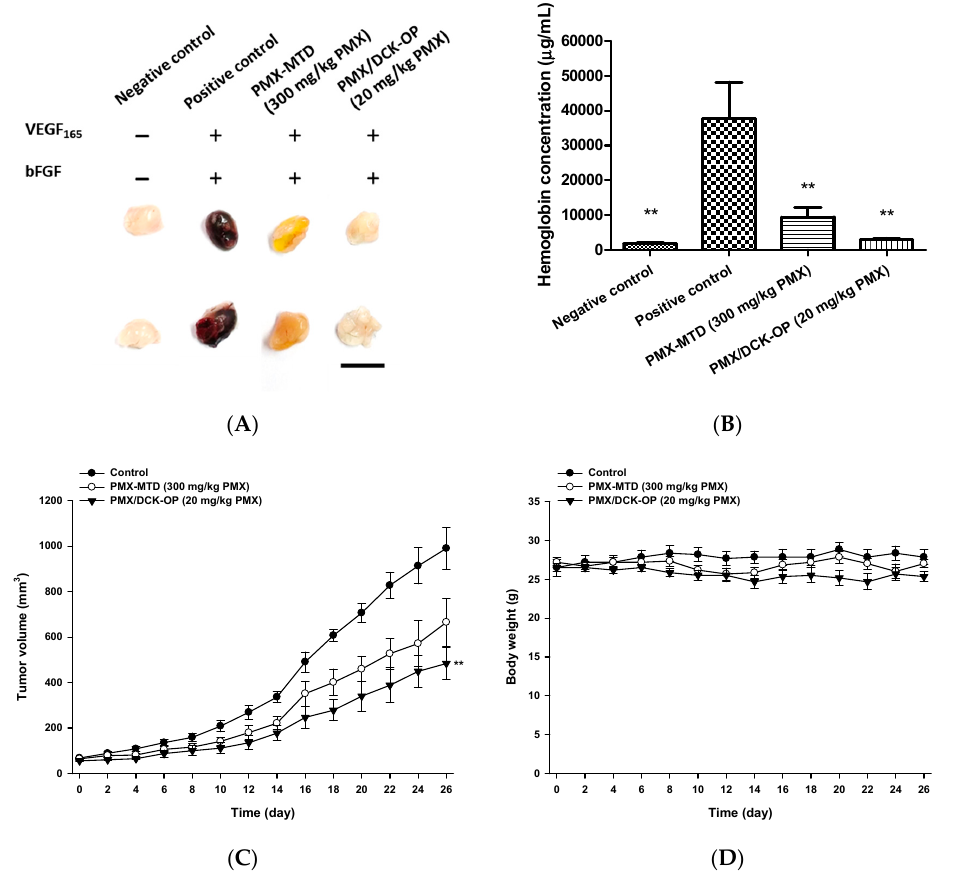
Figure 7. Anti-angiogenic and anti-cancer effect of MCT vs. MTD treatment of PMX. ( A ) Image of Matrigel plugs extracted from C57BL/6 mice inoculated with Matrigel with or without VEGF 165 and bFGF and receiving saline in the negative and positive control groups, intraperitoneal injection of PMX 300 mg/kg/week as MTD, and oral administration of PMX/DCK-OP 20 mg/kg/day (based on PMX) as MCT. ( B ) Quantification of hemoglobin content from Matrigel ( n = 5 per group). ( C ) Tumor growth profiles of A549 xenografted mice receiving saline as a control, intraperitoneal injection of PMX 300 mg/kg/week as PMX-MTD, and oral administration of PMX/DCK-OP 20 mg/kg/day (based on PMX) ( n = 6 per group). ( D ) Body weight profiles. Bar means 10 mm. Data are expressed as mean ± SEM. ** p < 0.01 compared to the control group.